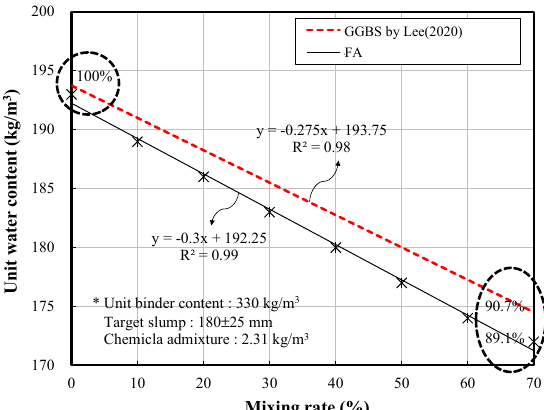
Figure 6. Results of the unit water content of OPC and FA compared with GGBFS as measured by Lee (adapted from [26]) in terms of the mixing rate.